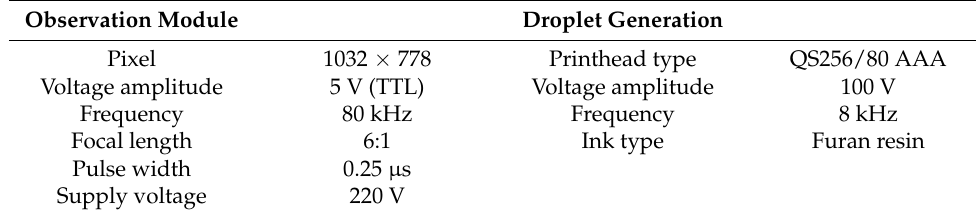
Table 1. Experimental